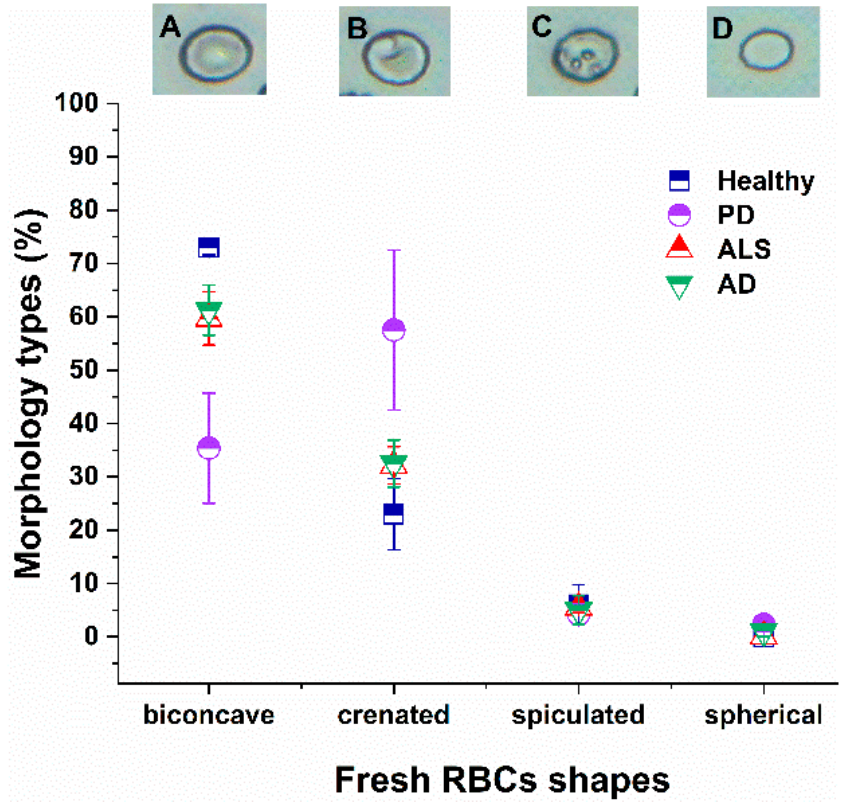
Figure 1. Optical images of the four different RBCs shapes (biconcave ( A ), crenate ( B ), spiculated ( C ) and spherocytic ( D )). Distribution of RBC morphological types (in percentage) in fresh healthy (navy squares), PD (violet circles), ALS (red triangles) and AD (green inverted triangles) cells. Mean values and SD; p values (NDD vs. healthy control group): p < 0.01 for biconcave shape of PD, AD and ALS, and for crenate shape of PD cells; and p < 0.05 for crenate ALS and AD cells. Four different cell shapes (biconcave, crenate, spiculated and spherocytic) are distinguished as previously reported for healthy RBCs [47]. The biconcave discoid shape (Figure 1A), characterized by a regular membrane protein network [28], is the dominant shape in fresh healthy cells (ca. 73%). Healthy RBCs also contain ca. 21% crenate shape (Figure